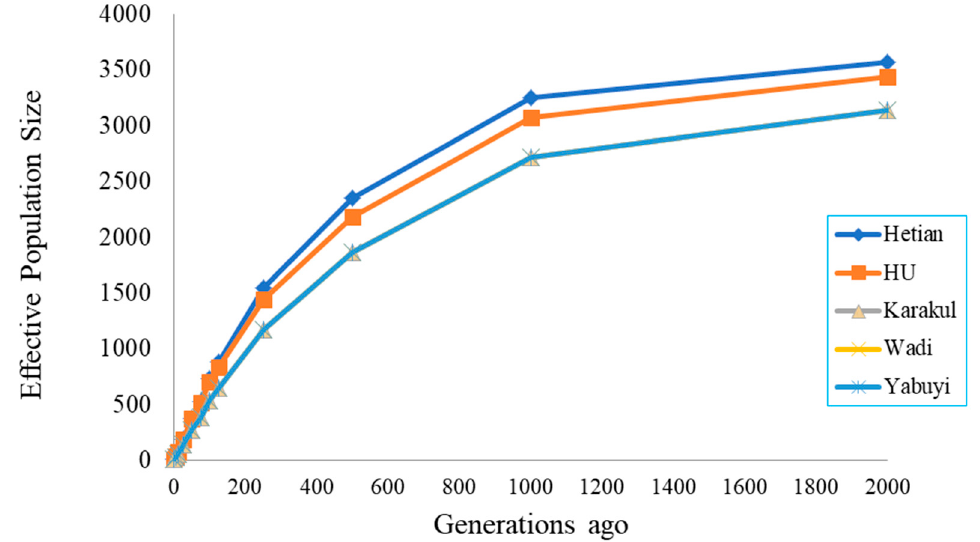
Figure 6. Estimated effective population sizes (Ne) over time for five Chinese native sheep breeds adapted to extremely dry and humid environments.